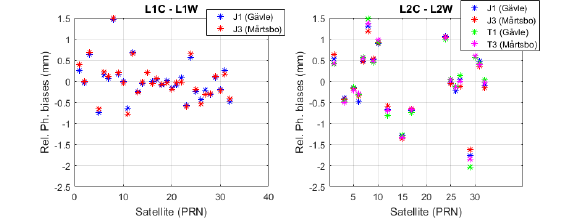
Figure 10: Javad and Trimble phase biases between signals on L1 and L2 on DOY 2 in Gävle and Mårtsbo